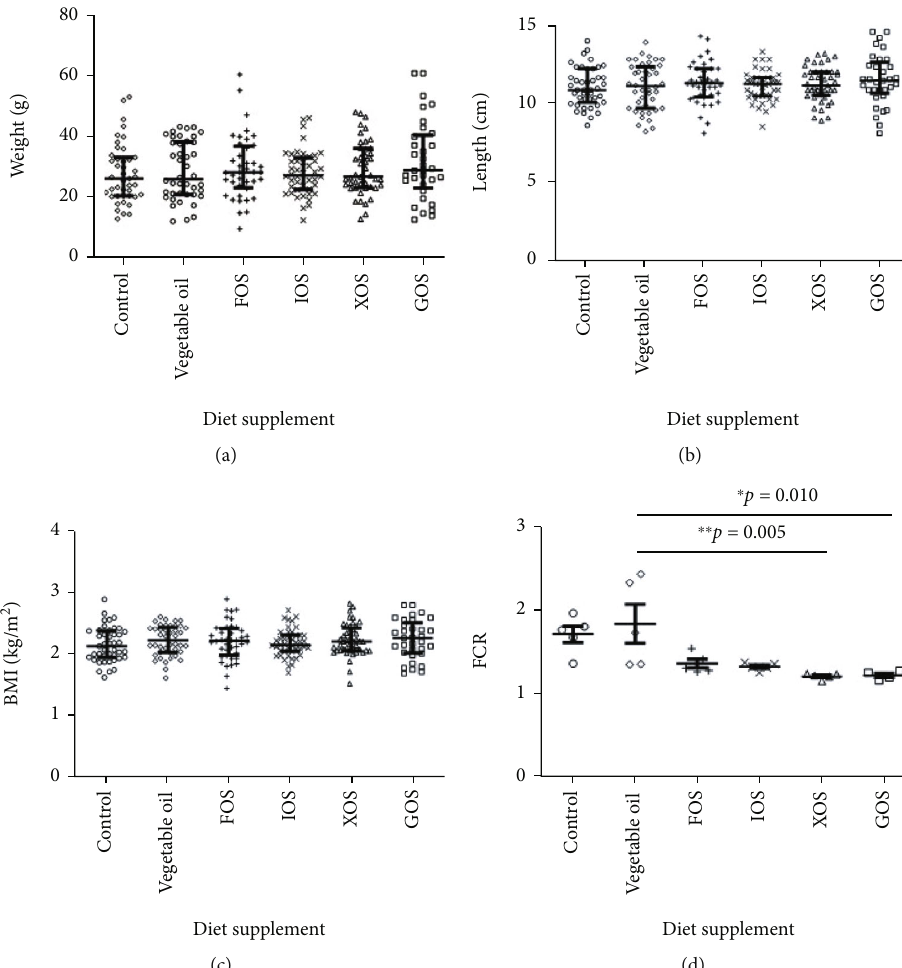
Figure 1: Growth performance of the one-month larval O. niloticus . The fi sh growth performance was evaluated by measuring the wet weight (a) and body length (b) and calculating the BMI of the fi sh (c). The FCR was also calculated (d). ∗ 0 : 01 < p < 0 : 05 ; ∗∗ p < 0 : 01 ; n = 33 − 45 for (a) – (c) and 5 for